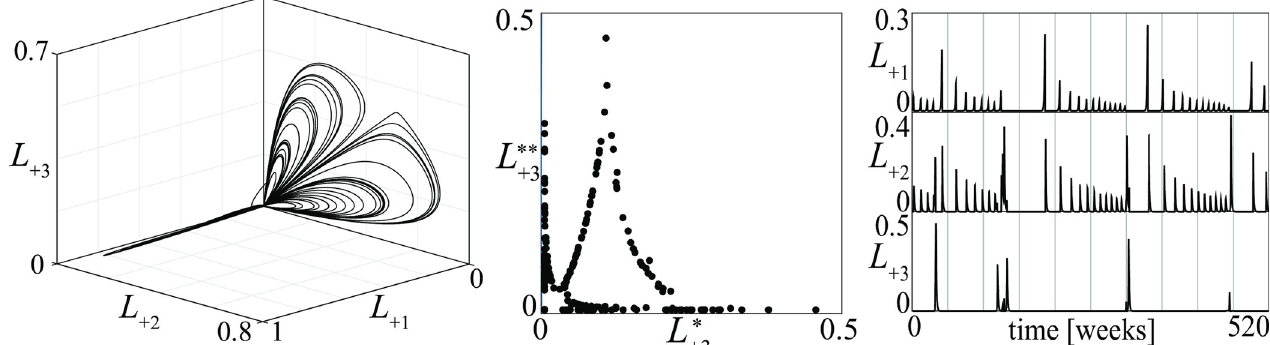
Fig 14. A military chaotic stalemate for a conflict of type (5) in Fig 13. ( a ) the stalemate in the three dimensional space of the losses L + and L �� are subsequent peaks of the losses of the third group; ( c ) ten years long segments of the corresponding time L � þ 3 þ 3